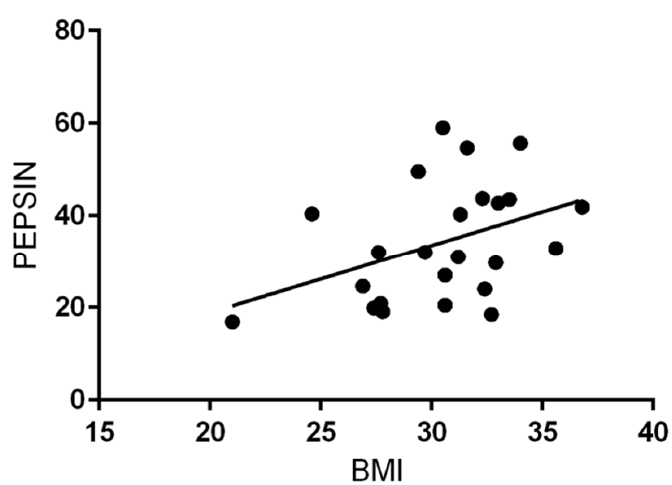
Figure 6. Liner regression scatterplot between BMI and salivary pepsin concentration. Statistically significant correlation ( p = 0.05, R 2 = 0.2).